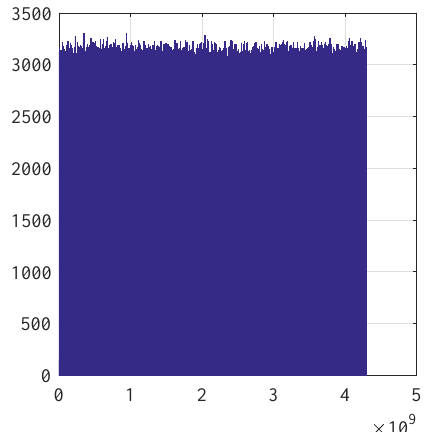
Figure 6. An example of a histogram of a generated sequence X ( n ) .